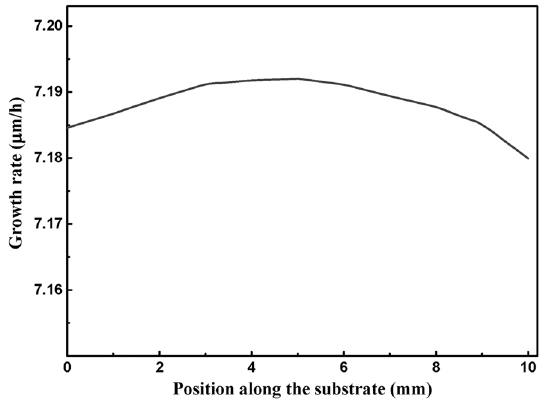
Figure 4. Predicted growth rate on the substrate by adsorption of Si and SiH.